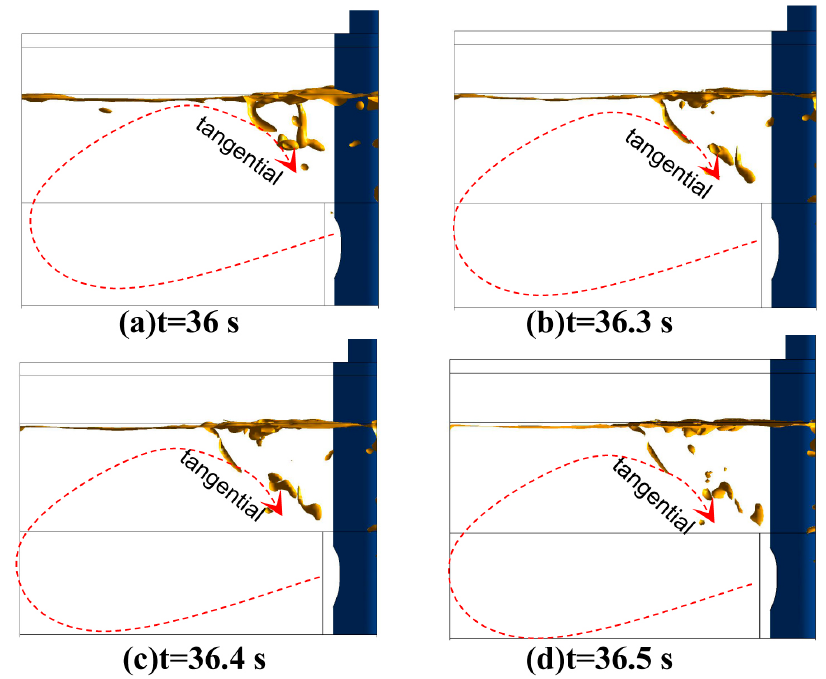
Figure 8. Transient deformation of slag layer after ( a ) 36 s, ( b ) 36.3 s, ( c ) 36.4 s, and ( d ) 36.5